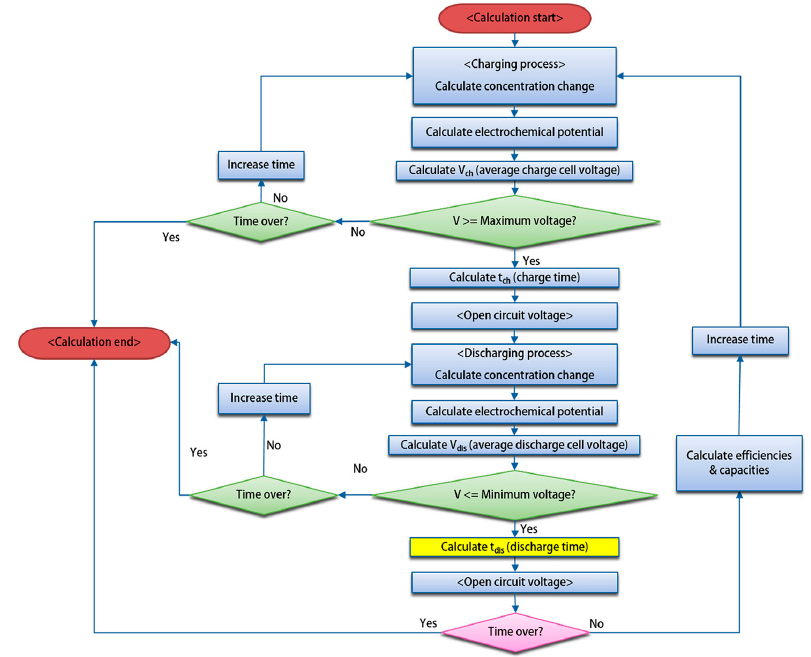
Figure 4. Flow chart of the VRFB simulation [38].